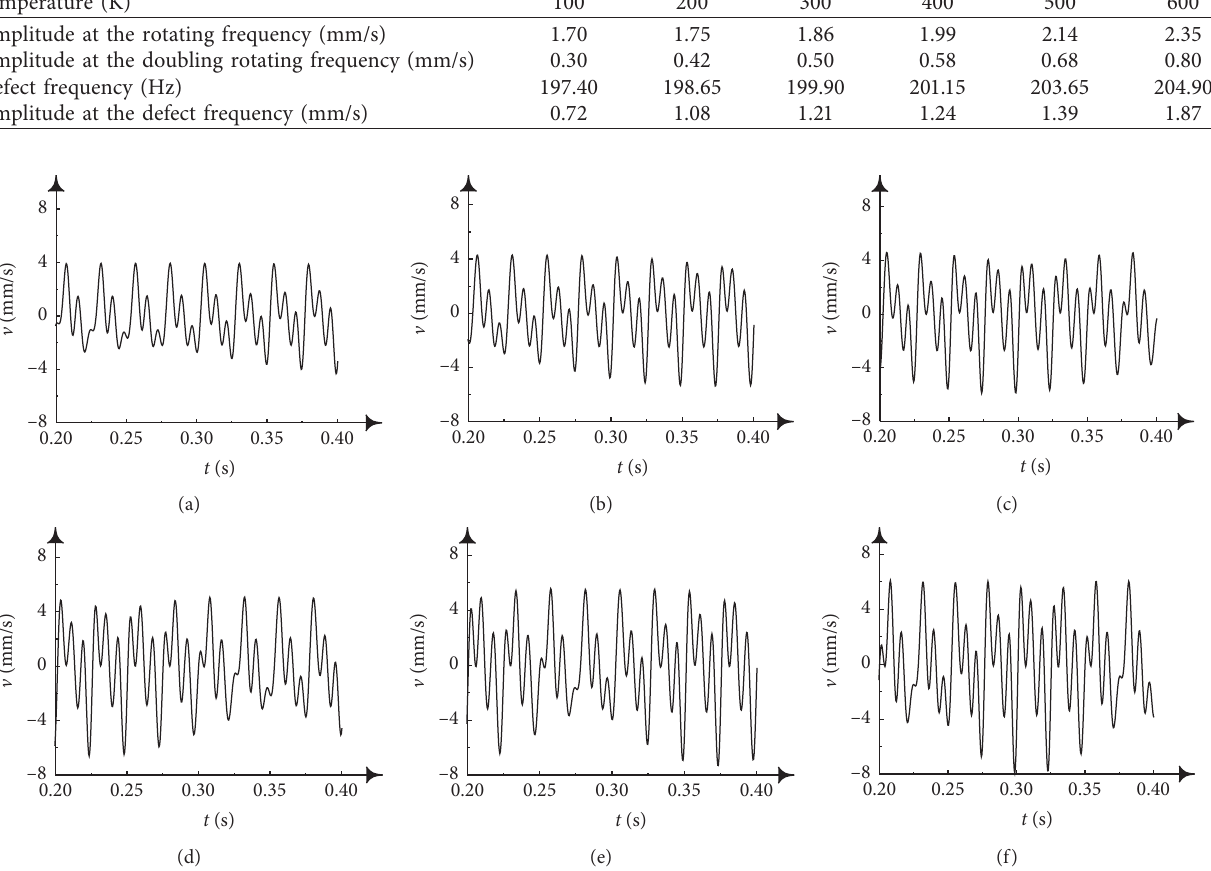
Figure 8: Vertical velocities of the outer ring in various temperatures. (a) T � 100K. (b) T � 200K. (c) T � 300K. (d) T � 400K. (e) T � 500K. (f) T �